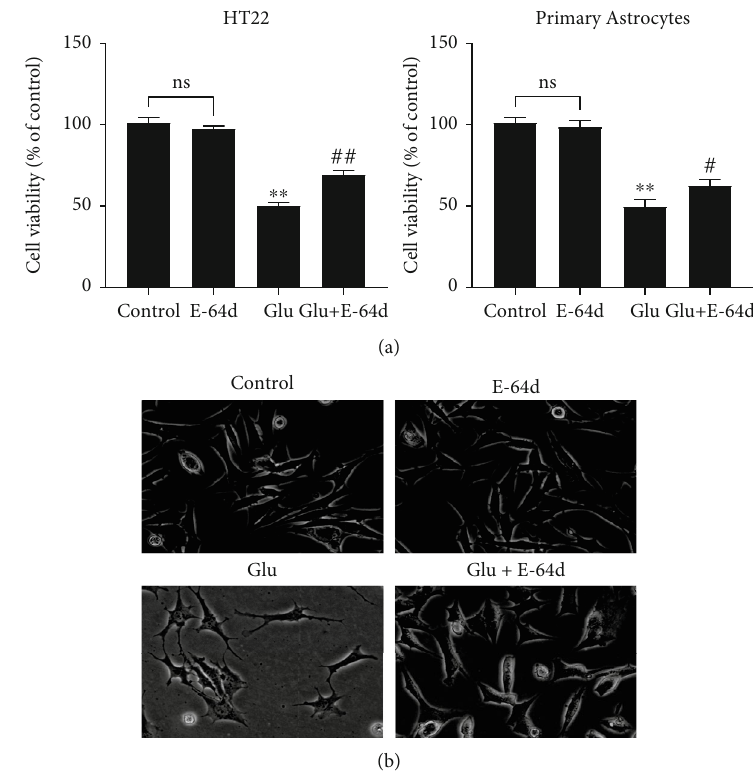
Figure 2: Protective e ff ect of E-64d on glutamate-induced injury in HT22 cells and primary astrocytes. (a) Cell viability was evaluated via the CCK-8. (b) Observation of HT22 cell morphology in each group via light microscopy ( × 10). The data are expressed as the mean ± SD . ∗∗ P < 0 : 01 vs. the Control group. # P < 0 : 05 , ## P < 0 : 01 vs. the Glutamate group. n.s.: not signi fi